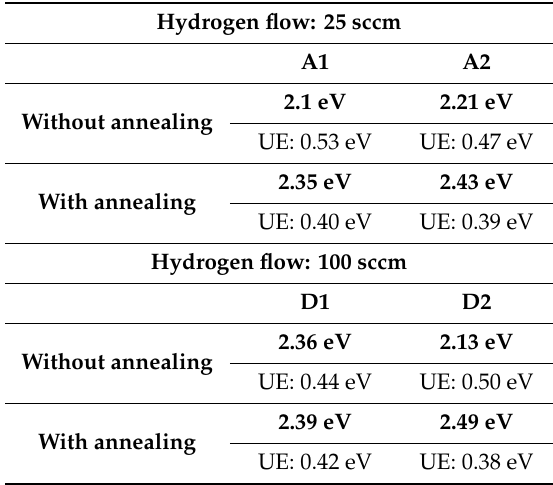
Figure 4. Energy band gap calculated for D1´ film with its corresponding Urbach energy. Table 2. Energy band gaps and Urbach